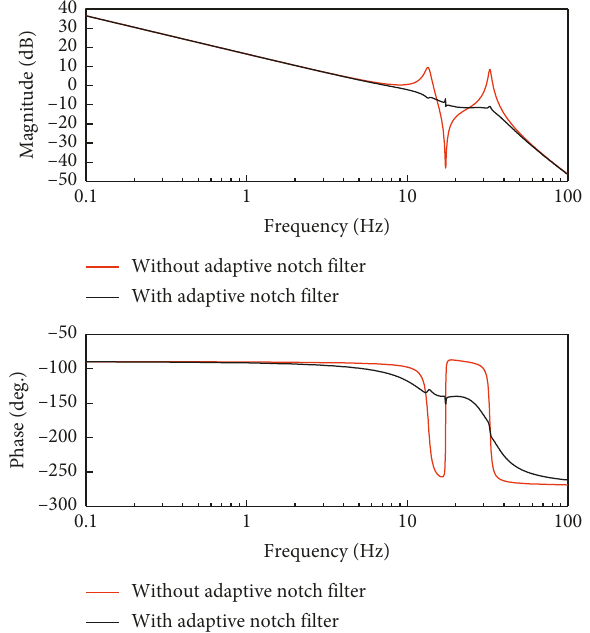
Figure 12: Amplitude-phase characteristic of shaking table